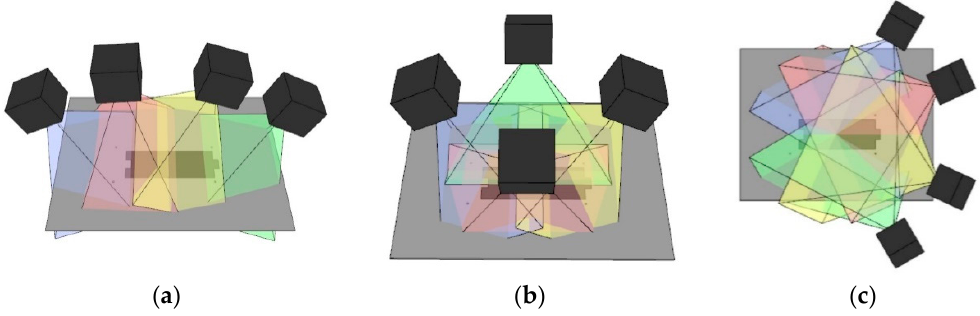
Figure 2. Typical layout patterns of the unit module of multi-camera ( a ) The arched layout pattern; ( b ) The annular layout pattern; ( c ) The half-annular layout pattern. Table 1. Comparison of three pitching angles for four-camera half-annular layout.